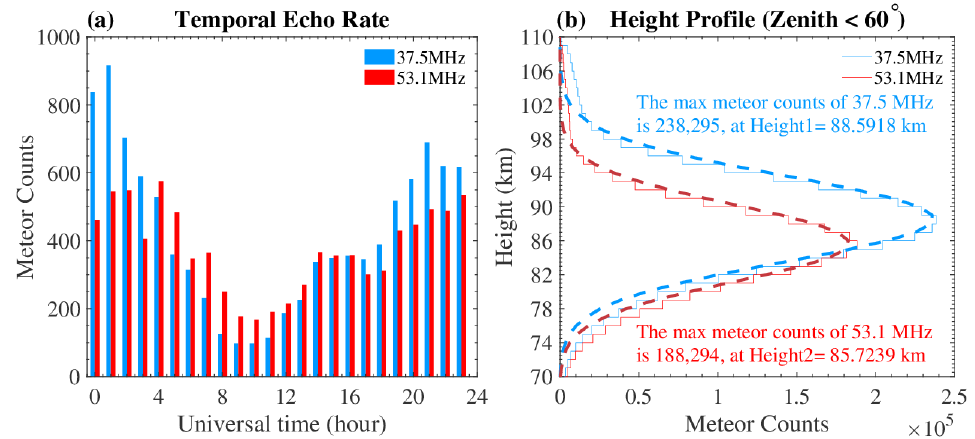
Figure 1. ( a ) Hourly detected meteor counts on 8 November 2013; the blue and red bars present the hourly counts observed by the 37.5 and 53.1 MHz MRs, respectively. ( b ) Height distributions of the meteor counts (solid lines in 1 km bins) from 1 November 2013 to 31 December 2014, and the curves fitted to the counts (dashed lines) assuming a Gaussian distribution; the meteor peak height and corresponding meteor count are also labeled for each MR.